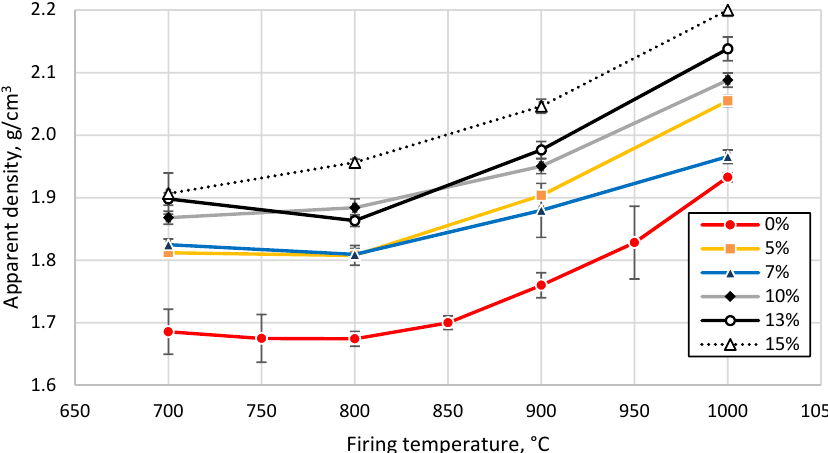
Figure 9. Apparent density of tested clay-glass ceramic materials after sintering at temperatures from 700 up to 1000 °C. The content of glass in wt% is in the legend.